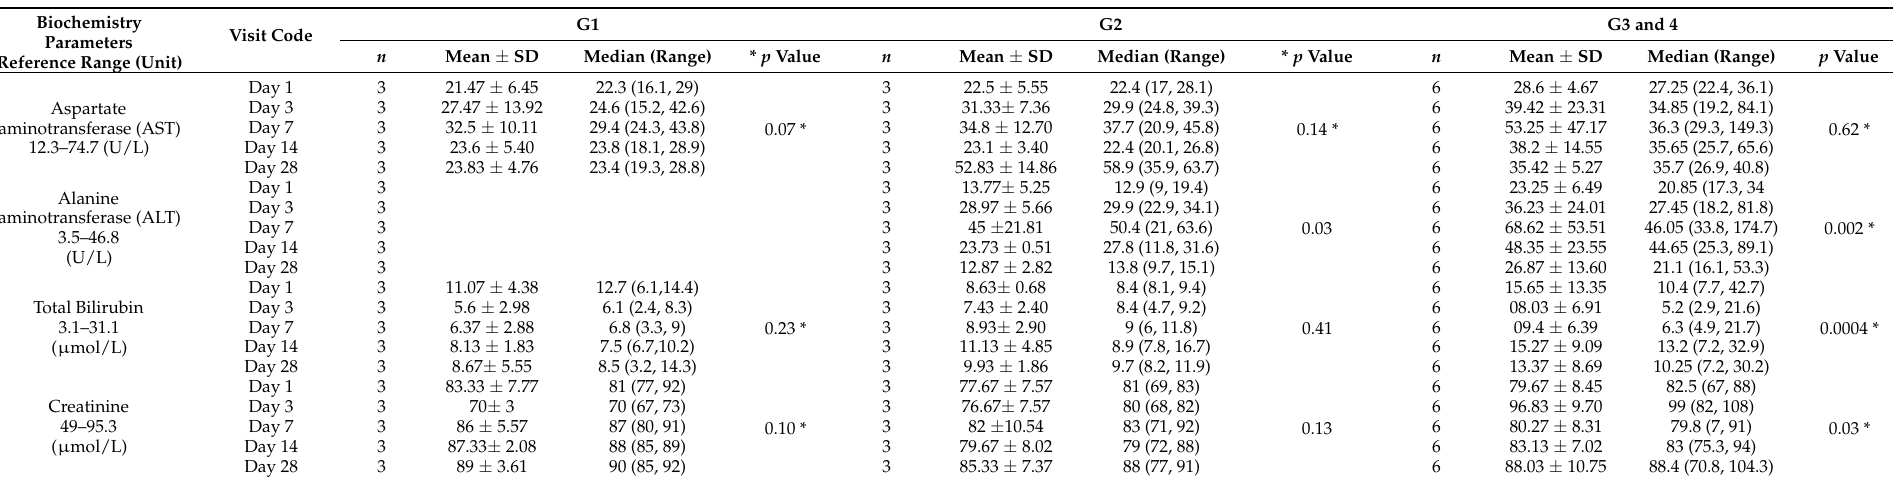
Table 5. Results of the biochemistry test for the first 28 days of administration of M. senegalensis in the study groups 1, 2, 3 and